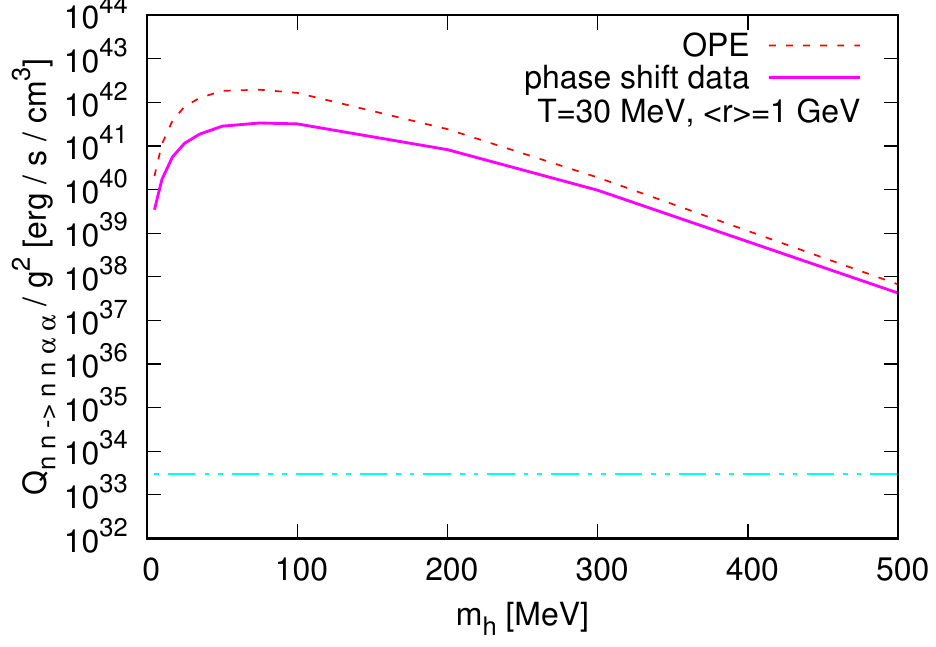
Figure 4 . Energy loss rate due to Goldstone boson emission from nuclear bremsstrahlung processes nn ! nn(cid:11)(cid:11) divided by the Higgs portal coupling g 2 , for various light Higgs boson mass m h . The rates are calculated using the one-pion exchange (OPE) approximation (dashed) and the SP07 global (cid:12)ts for the total pp elastic cross section (solid), and assume charge symmetry, i.e. (cid:27) nn = (cid:27) pp . Here we take the non-degenerate (ND) limit only, and set proto-neutron star core temperature T = 30 MeV and neutron fraction X n = 1. For all m h values we assume the radial (cid:12)eld vacuum expectation value is h r i = 1 GeV. Also shown is Ra(cid:11)elt’s analytical criterion on the energy loss rate per unit volume Q X in eq. (5.1)